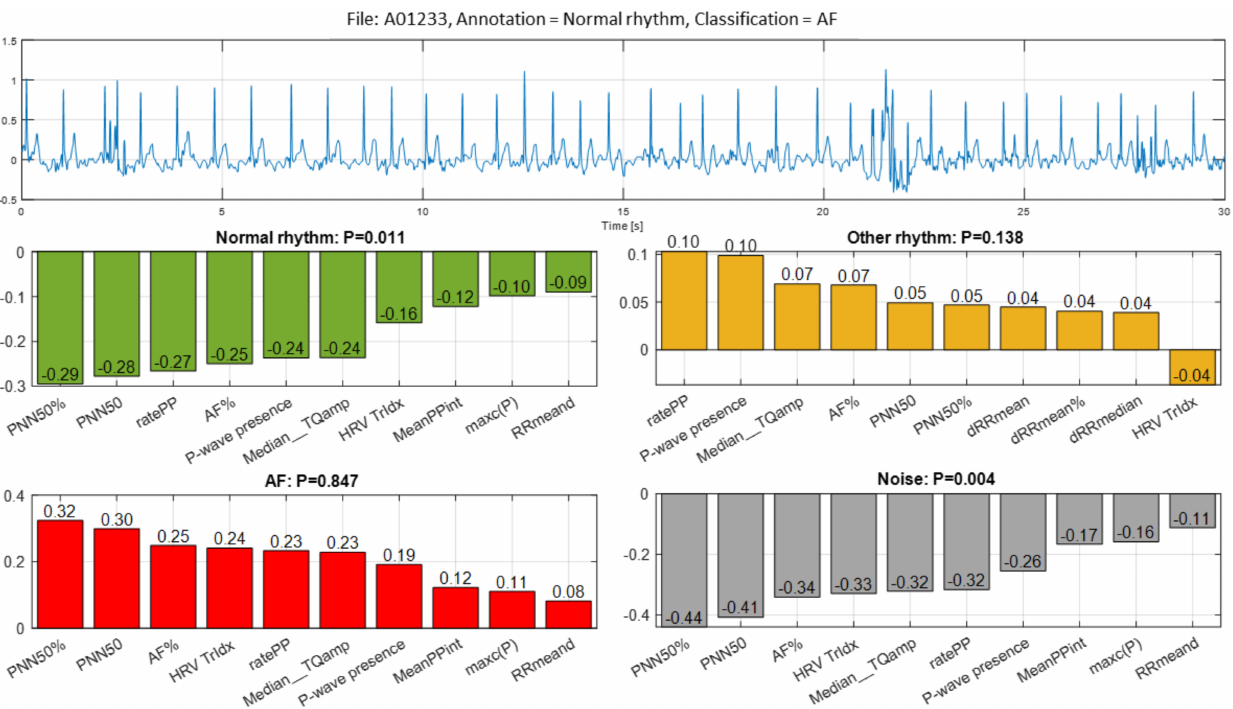
Figure 12. ECG example (file A01233) of erroneously classified Normal rhythm as AF. The single-lead ECG strip is representative to peak artifacts and significant variation of RR intervals in some parts of the record. Visual diagnosis of other dysrhythmias such as atrial flutter and multifocal atrial tachycardia cannot also be safely excluded. The barplots represent the Case Feature Importance of the top-10 ranked features, which maximally contribute to the output classification probability (P) of four rhythms. The ECG strip is definitively detected as AF ( p = 0.847) based on HRV and atrial activity estimation, although Other rhythm (P = 0.138) is also weakly indicated by DenseNet-3@128-32-4